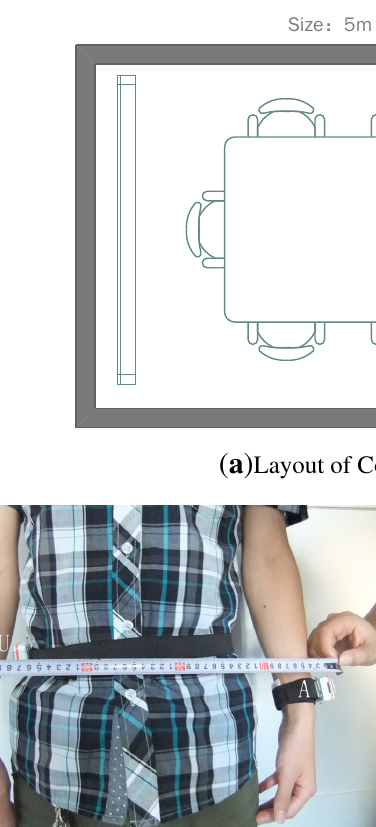
Figure 2. Experimental layout for indoor environment and sensor